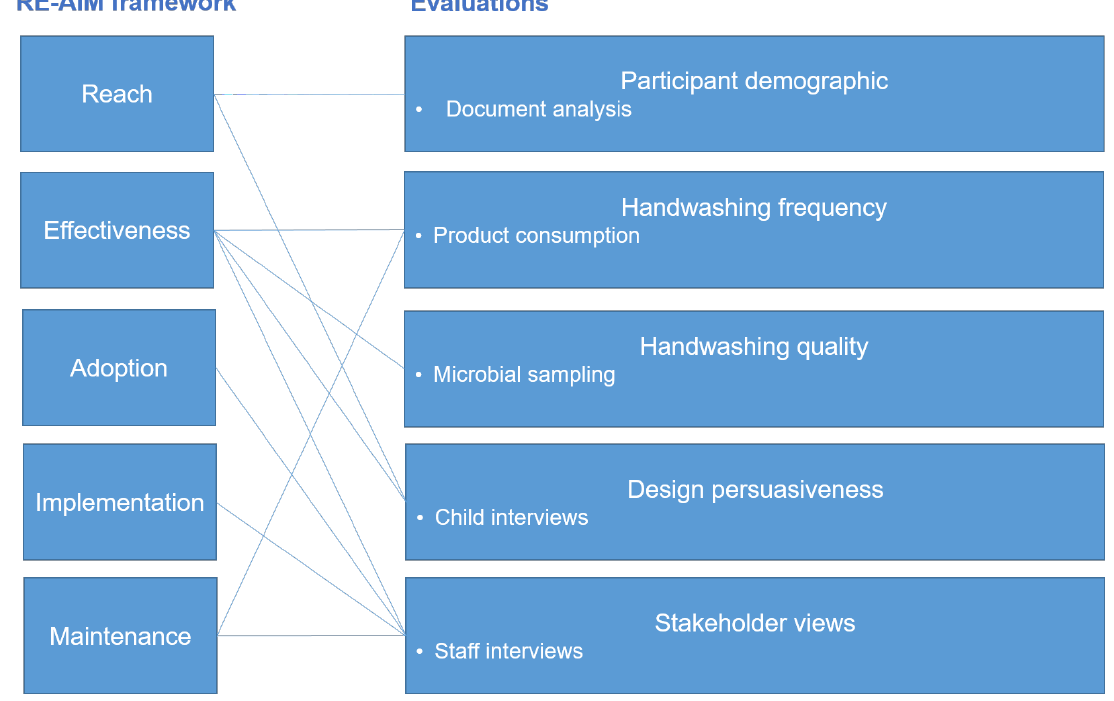
Figure 2. Overview of evaluation methods.